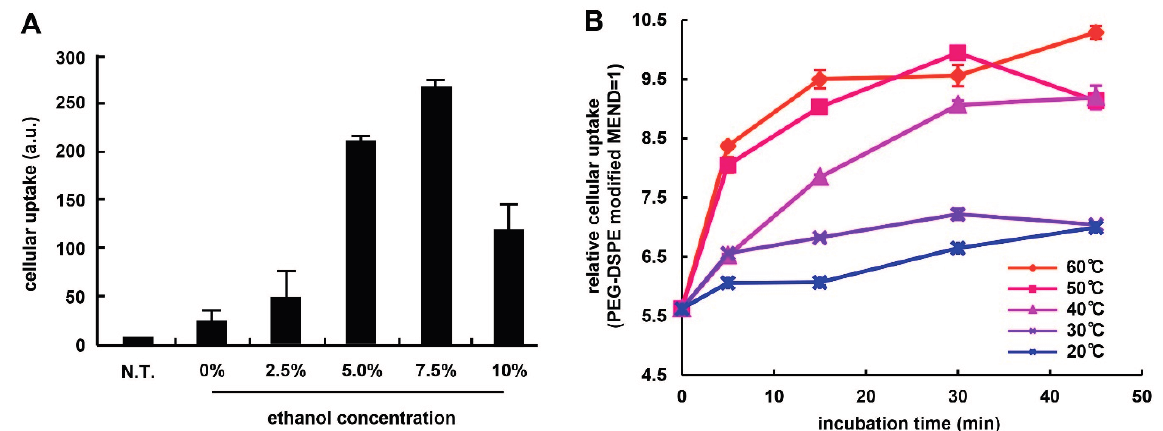
Figure 1. ( A ) The effect of ethanol concentration on modifying the ligand on the surface of the MENDs. MENDs were incubated with the ligand derivatives in citric buffer (pH 5.0) containing ethanol 0–10% at 45 °C for 20 min. The amount of cellular uptake of the MENDs was evaluated by flow cytometry (FCM). Data represents mean ± S.D. ( B ) The effect of incubation temperature in the post-modification step. When the temperature and incubation time were varied from 20 (blue), 30 (purple), 40 (pink), 50 (orange), and 60 °C (red), and 5– 45 min, respectively, the cellular uptake of RGD-MENDs at 2 h after the transfection was evaluated by flow cytometry. Data represents mean ± S.E.M.